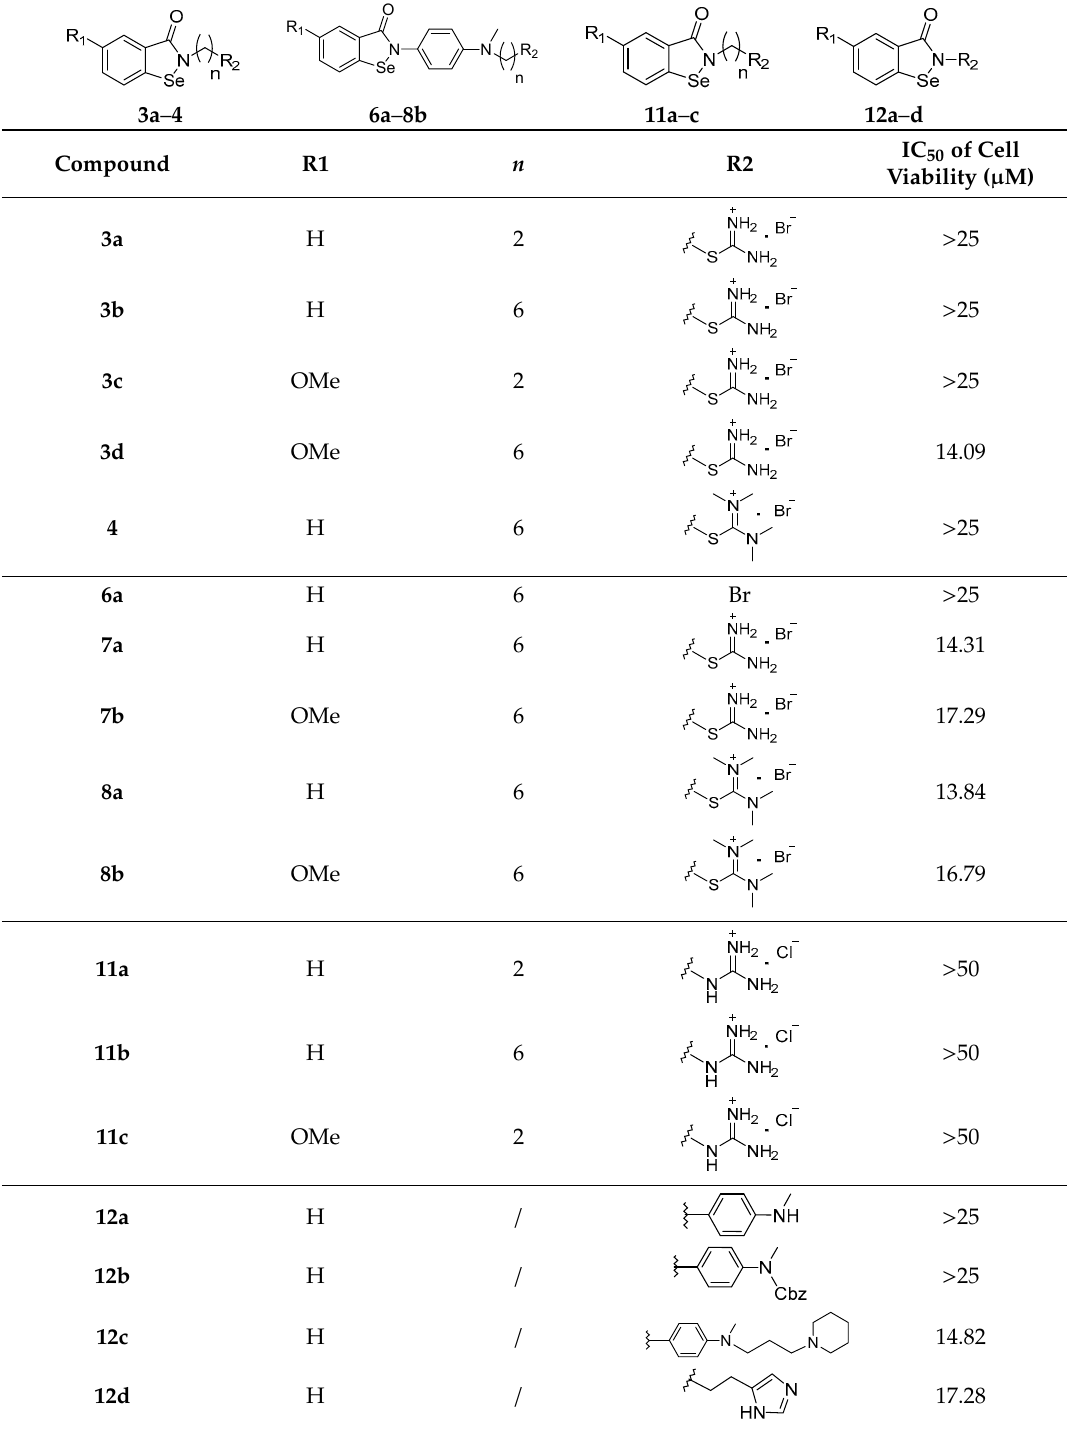
Table 1. IC 50 of the compounds in an EBC-1 cancer cell line.